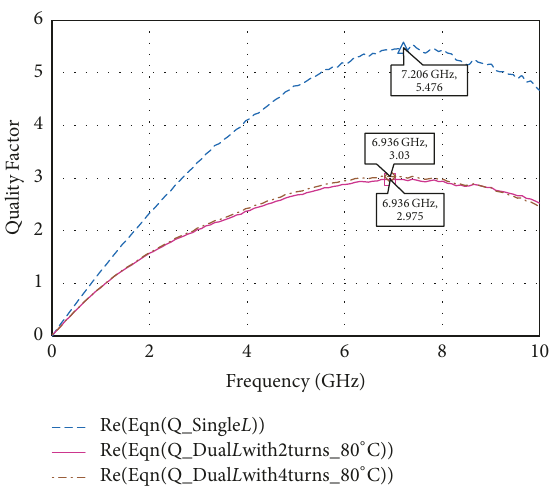
Figure 7: Quality factor of tunable